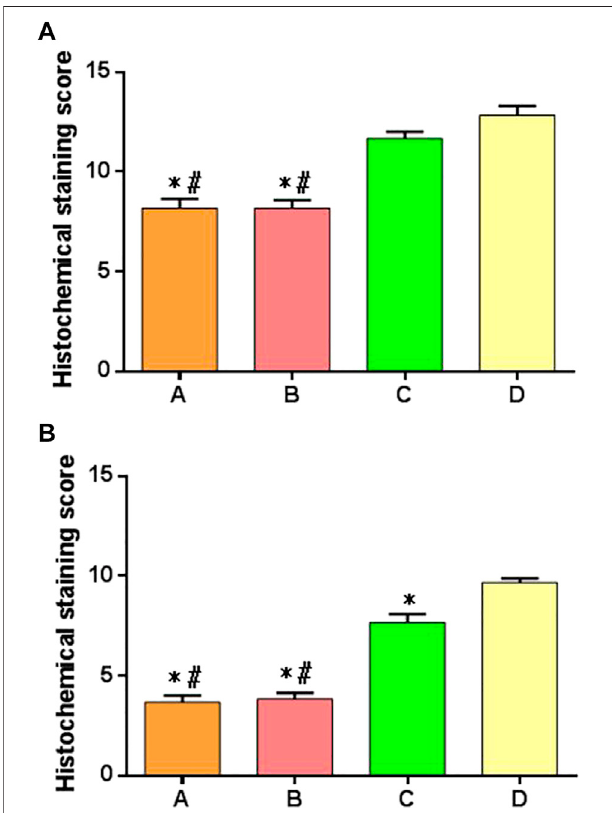
FIGURE 12 | Histologic scores of cartilage repair of postoperative specimens in each group. (A) Specimen score of each group at 6 weeks after surgery; (B) specimen score of each group at 12 weeks after surgery. *: signi fi cant difference compared with group D; # : there was a signi fi cant difference when compared with group C ( p <